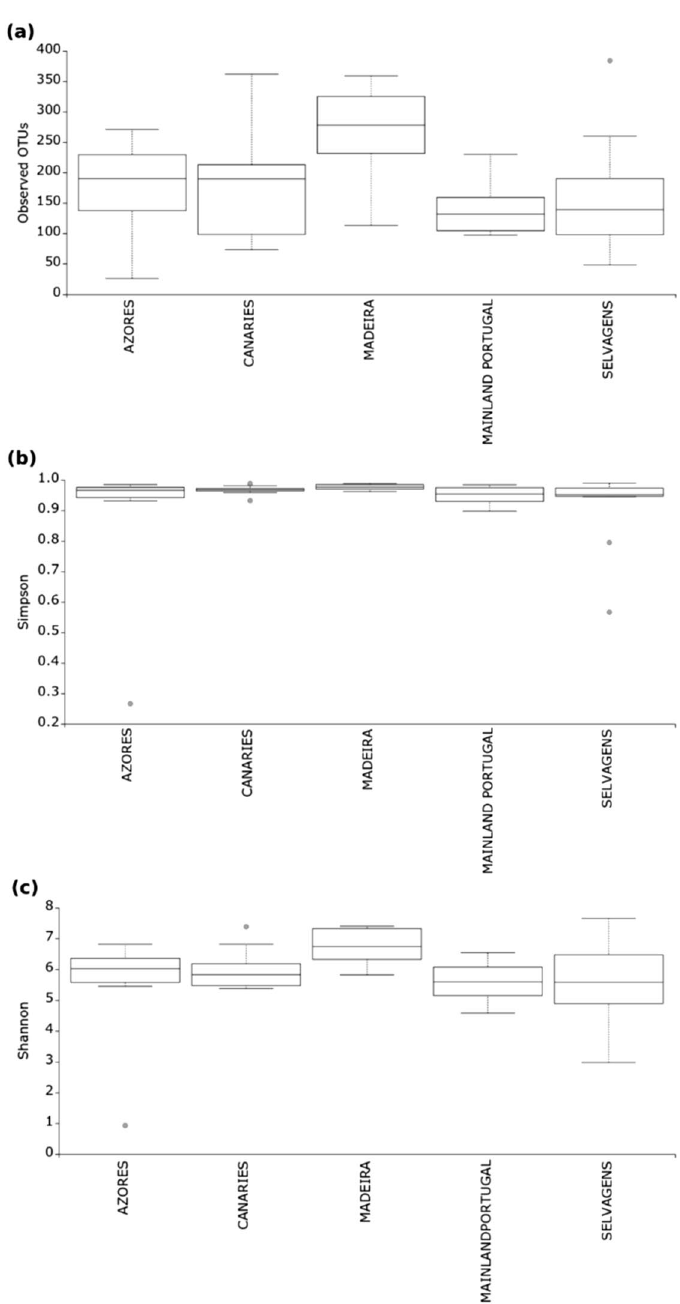
Figure 3. Alpha diversity indices based on Number of OTUs: ( a ) Simpson similarity ( b ) and Shannon function ( c ) for 5 intertidal populations (with 10 replicates each) of the microbiome of the mollusc Phorcus sauciatus in the Atlantic Ocean (mainland Portugal and the islands of Madeira, Selvagens, Azores and the